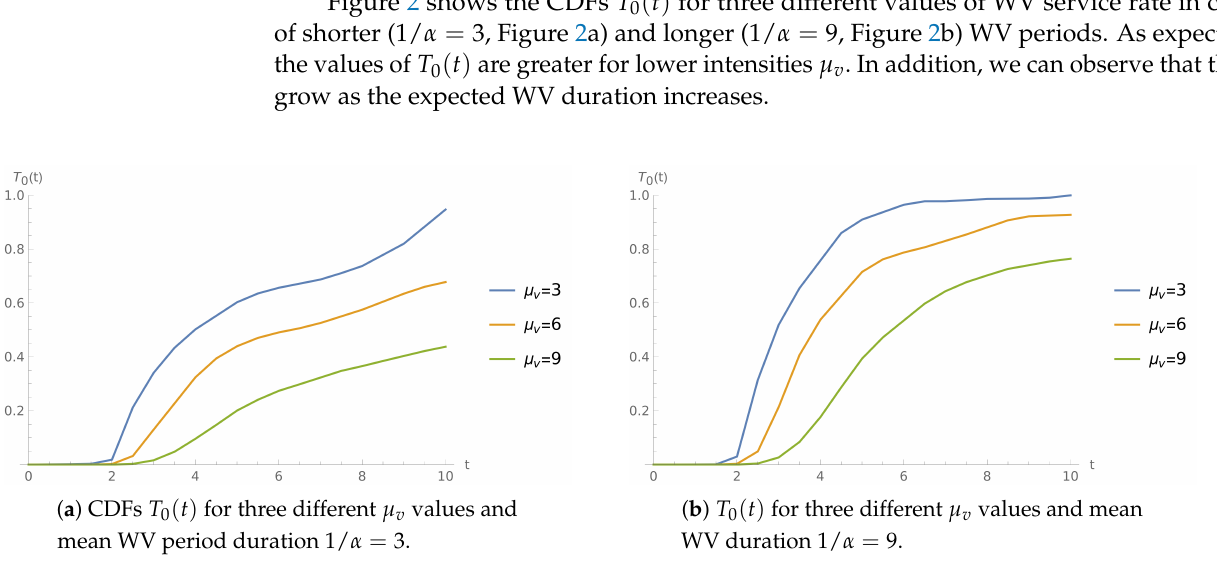
Figure 2. The time to buffer overflow CDFs for µ =